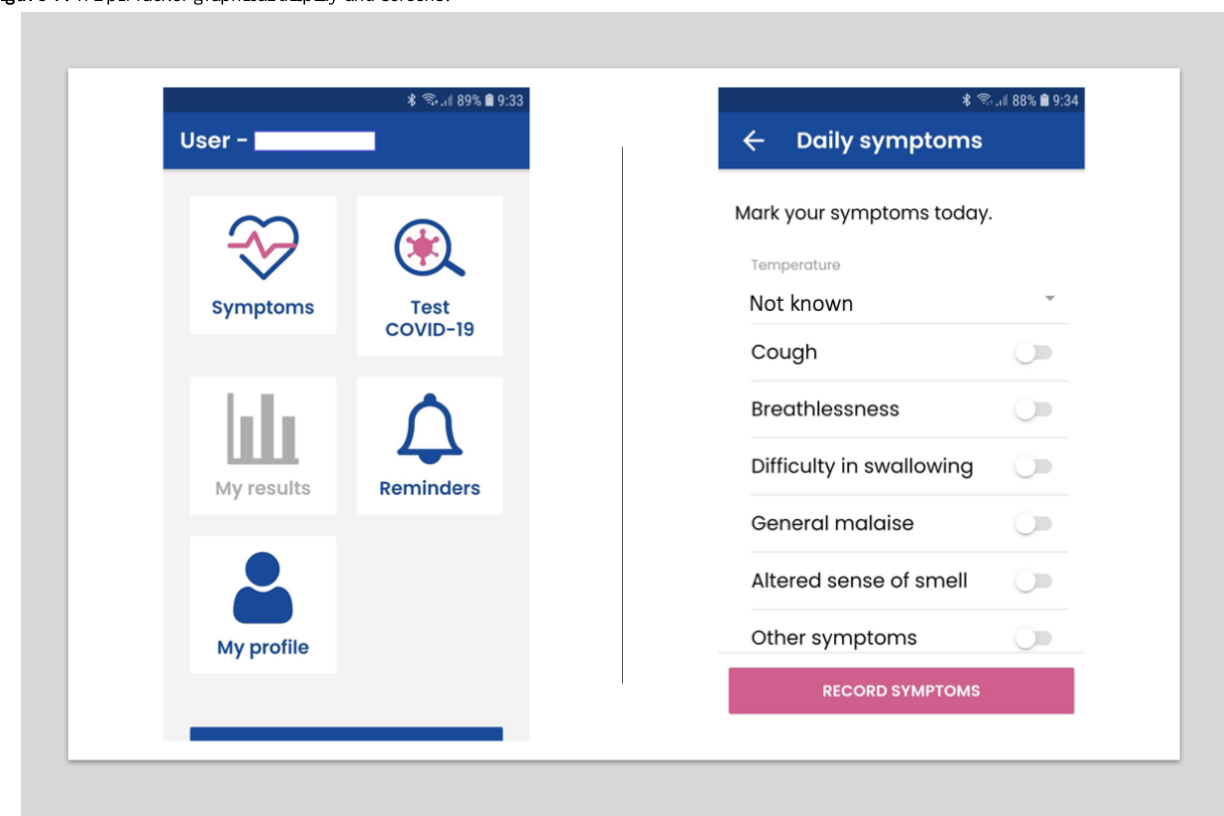
Figure 1. HEpiTracker graphical display and